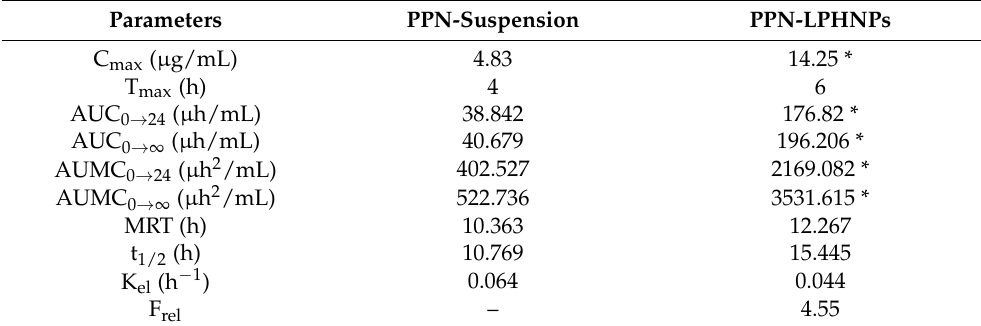
Table 6. Pharmacokinetic parameters of PPN-LPHNPs and PPN suspension after a single-dose administration in albino Wistar